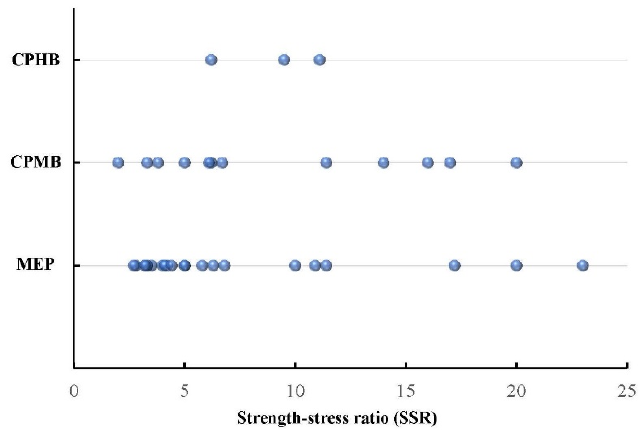
Figure 23. The distribution of excavation procedures based on SSR.